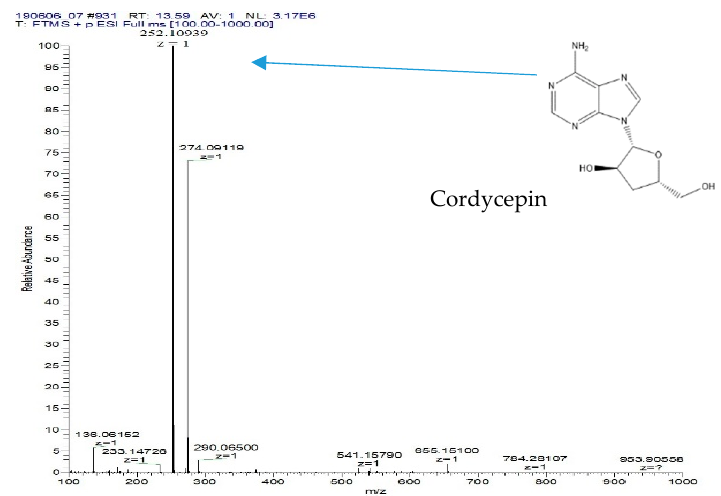
Figure 9. Total ion chromatogram and mass of cordycepin detected in the CM4 fraction.